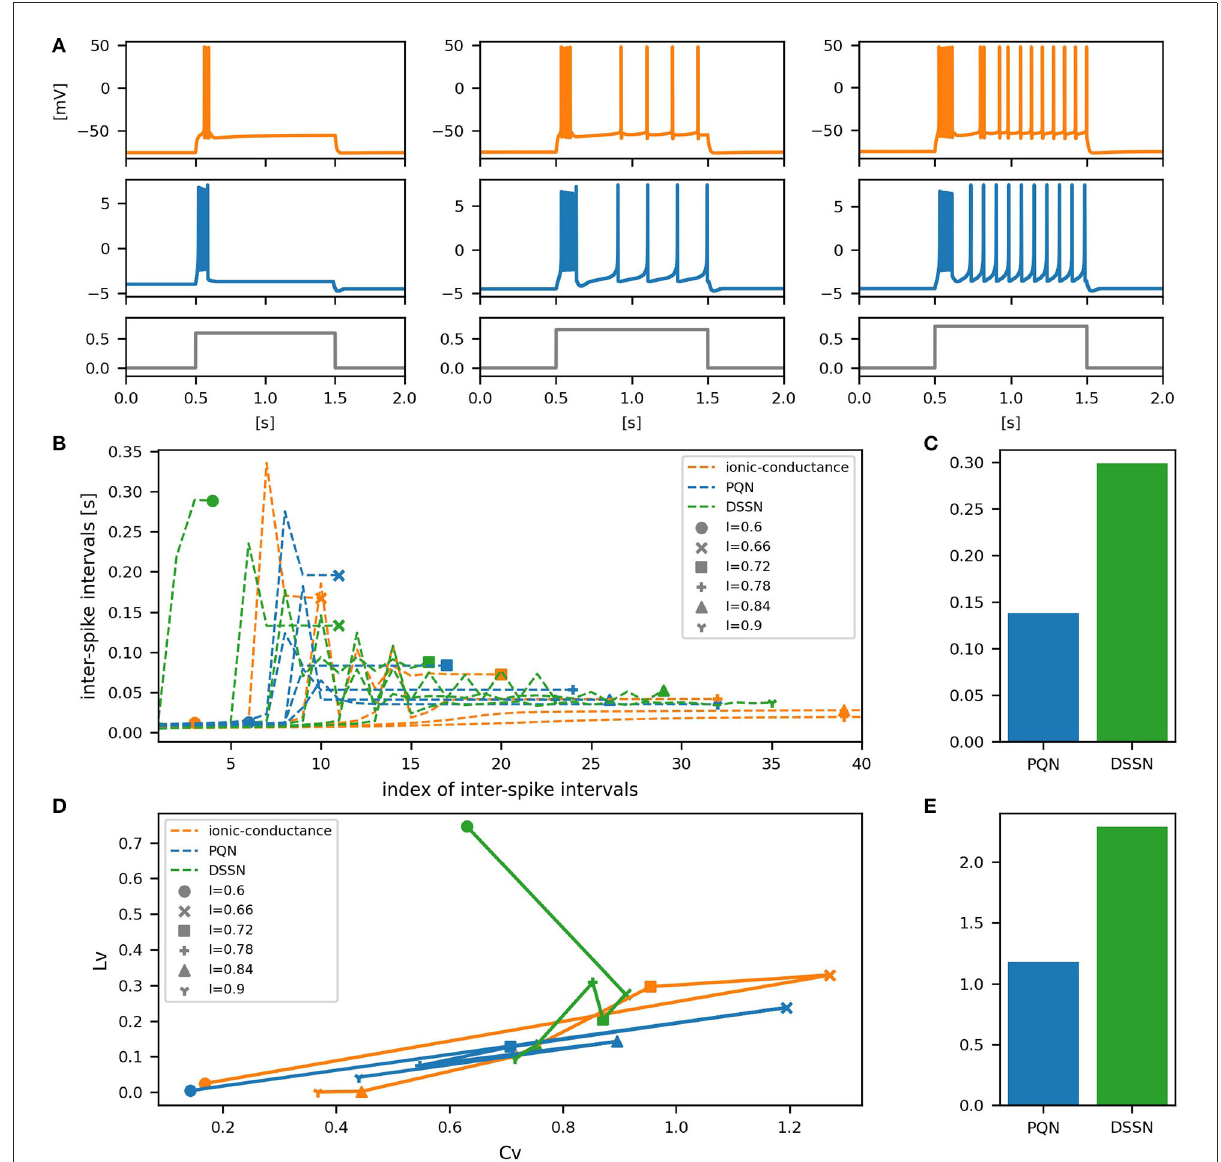
FIGURE10 Waveforms and spiking properties in IB mode. (A) Waveforms of the ionic-conductance model (orange) and the PQN model (blue). Gray lines represent stimulus inputs. (B) The transitions of ISIs are shown while increasing the magnitude of the stimulus input. (C) The mean square errors of the PQN model and the DSSN model with the ionic-conductance model over the data points shown in (B) . (D) Values of the C V and L V were calculated from the waveforms and plotted while varying the magnitude of the stimulus inputs. The waveforms used here are the same as that used in (B) . (E) The mean square errors of the PQN model and the DSSN model with the ionic-conductance model over the data points shown in (D) .